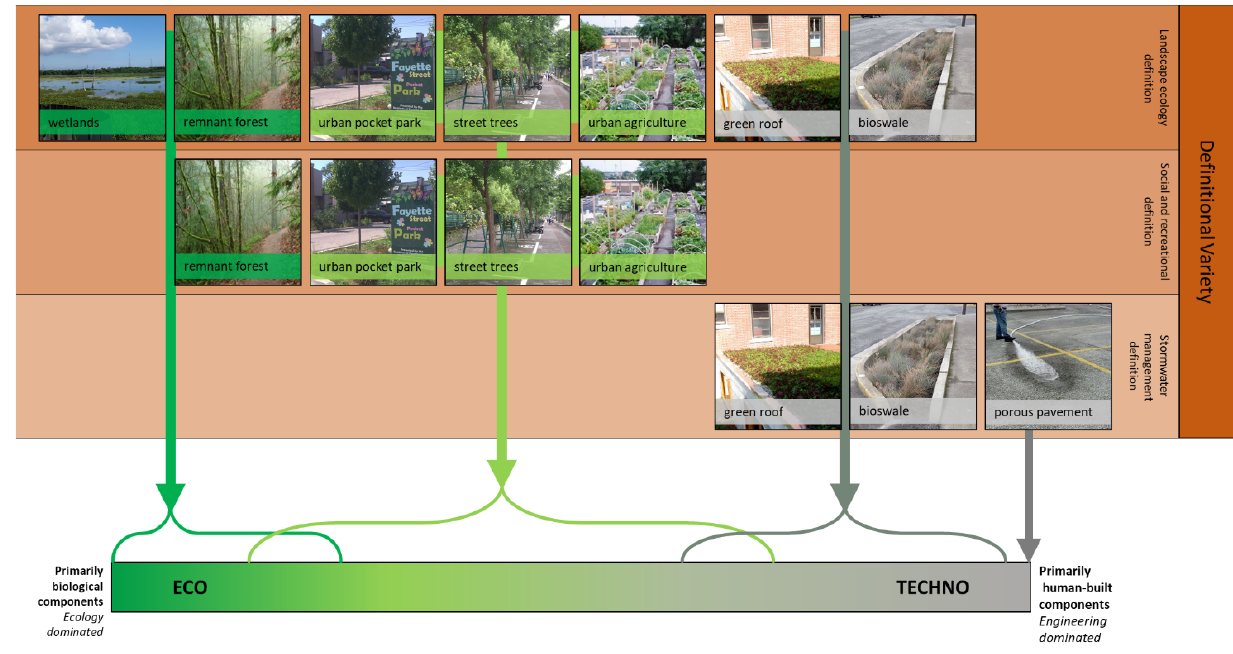
Figure 2. Facility types most commonly associated with, but usually implicitly, three distinct definitions of